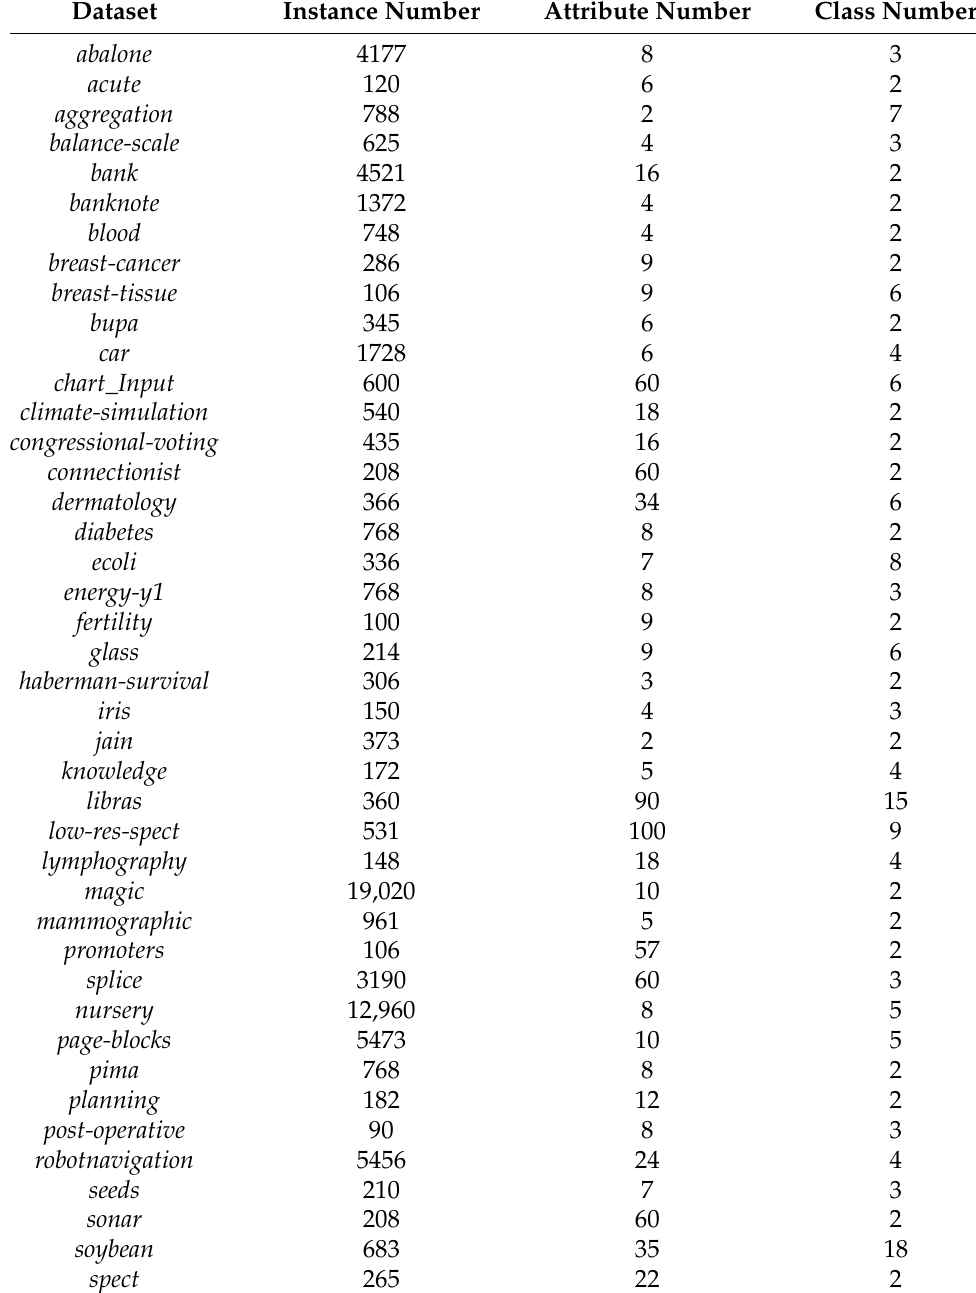
Table 2. Descriptions of 50 UCI datasets used in the